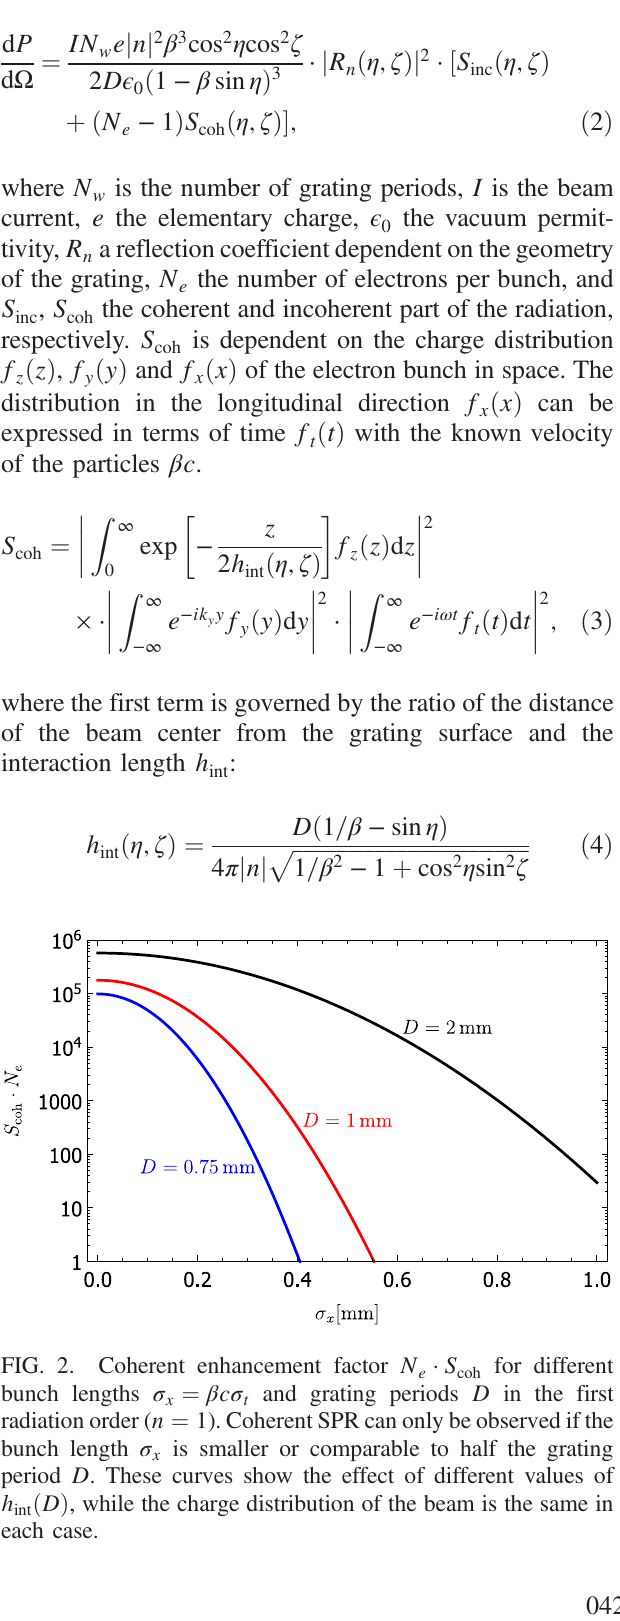
FIG. 2. Coherent enhancement factor N e · S bunch lengths σ x ¼ β c σ t and grating periods D in the first radiation order ( n ¼ 1 ). Coherent SPR can only be observed if the bunch length σ x is smaller or comparable to half the grating period D . These curves show the effect of different values of h ð D Þ , while the charge distribution of the beam is the same in int each